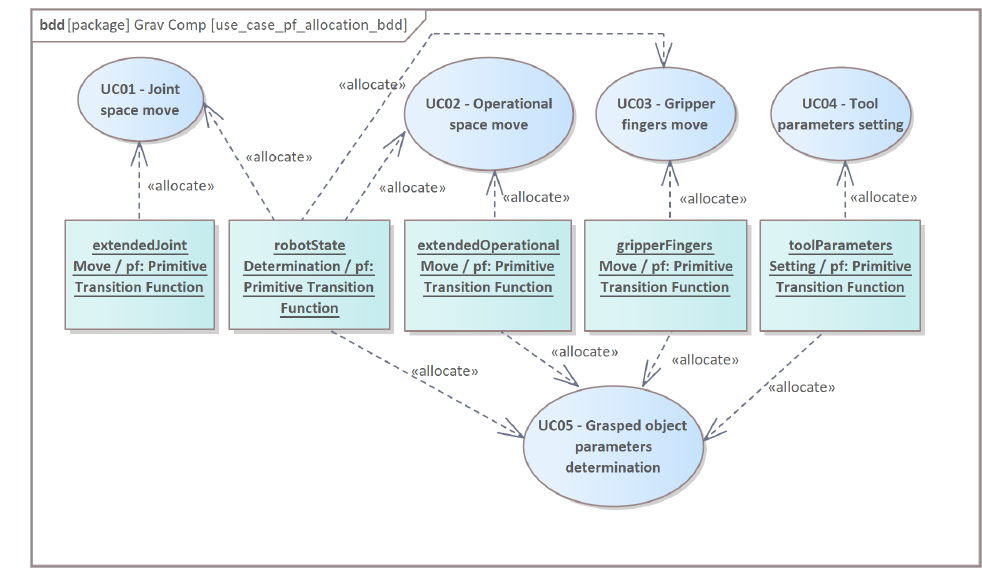
Figure 3. Use case allocation in primitive transition functions of